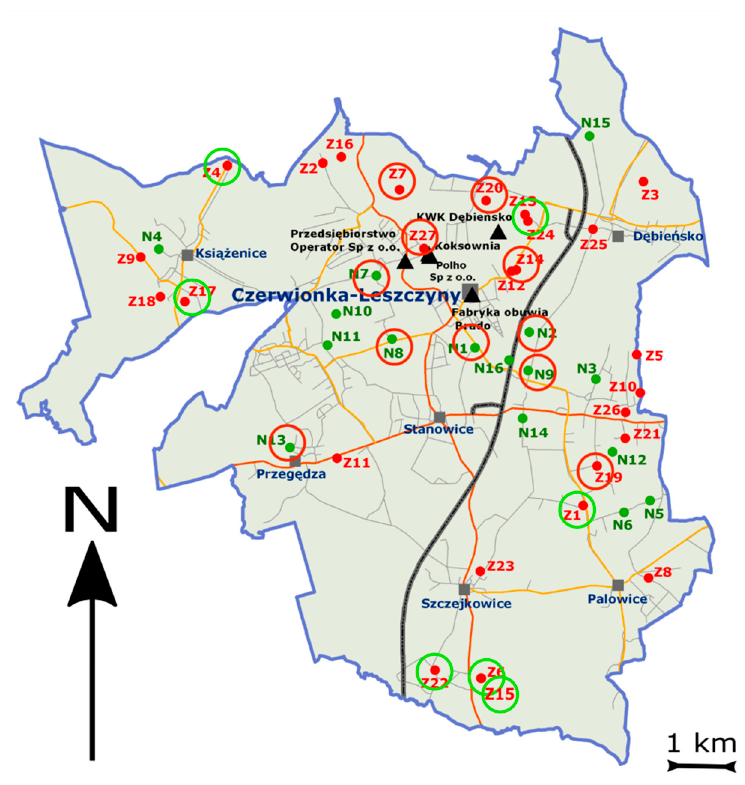
Figure 5. Sample localization (N and Z)—red circles at locations with high BC/SOC (>10) and green circles at a location with low BC/SOC (<5). The red color (Z points) for areas with PAH contamination and the green points (N) for the areas with no PAH contamination. The black triangles are the main sources of BC emission.